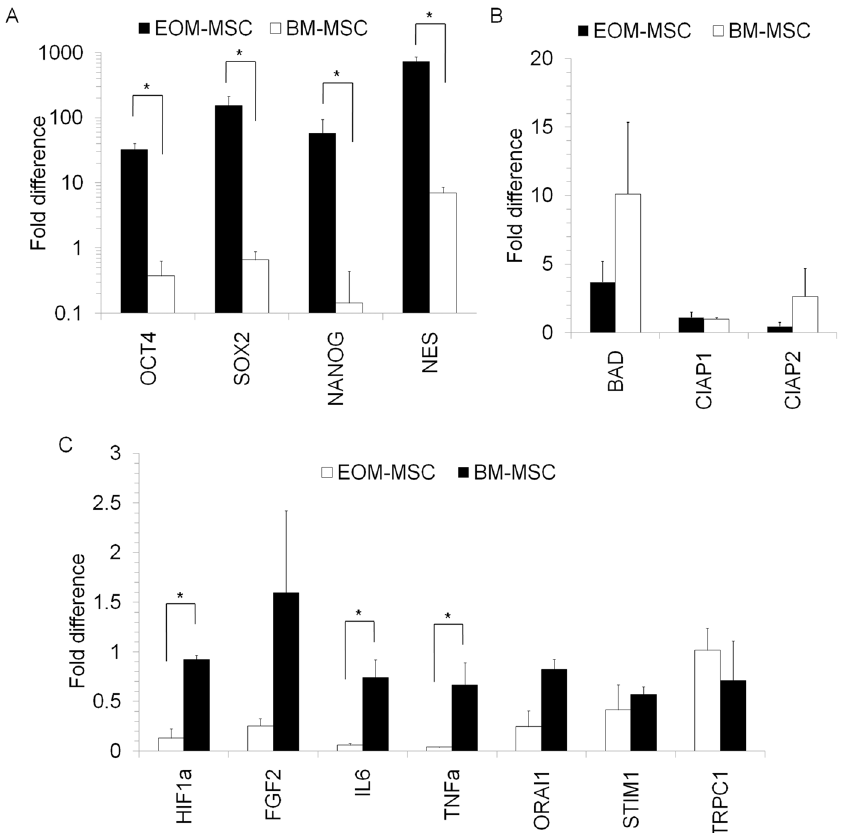
Fig 6. Gene expression analysis in EOM-MSC. (A) Expression levels of transcription factors OCT4, NANOG and SOX2 and neuronal lineage related gene NES in EOM-MSC was analysed by real-time PCR and compared with BM-MSC. mRNA expression levels of (B) apoptosis related genes BAD, cIAP1, cIAP2 and (C) other factors HIF1 α , FGF2, IL6, TNF α as well as calcium channel related genes ORAI1, STIM1, TRPC1 were determined in EOM-MSC and BM-MSC by real-time PCR. The expression levels of the genes were normalized to GAPDH expression levels in the respective samples. Values are mean ± SD, n = 3 – 5 * p <